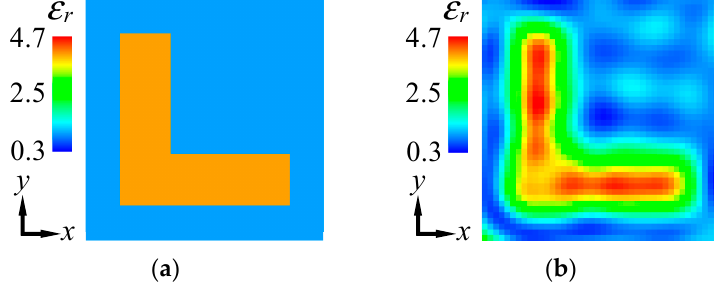
Figure 15. Extraction result of incident field with unknown obstacles: ( a ) total field obtained by simulation, where the target object is removed and obstacles are included in the computational domain, and ( b ) extracted incident field with the proposed method ( M = 200).